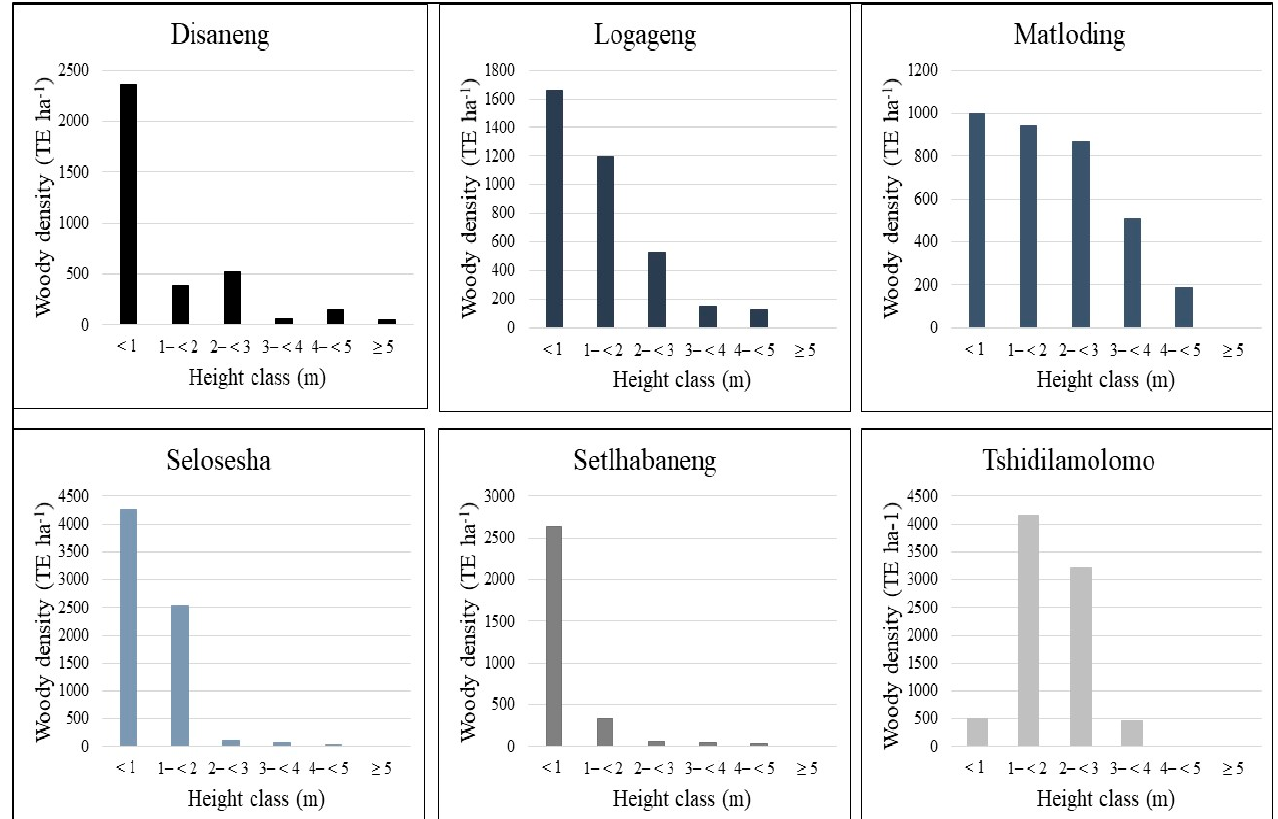
Figure 2. Combined density (TE ha − 1 ) of woody species in different height classes around each village.